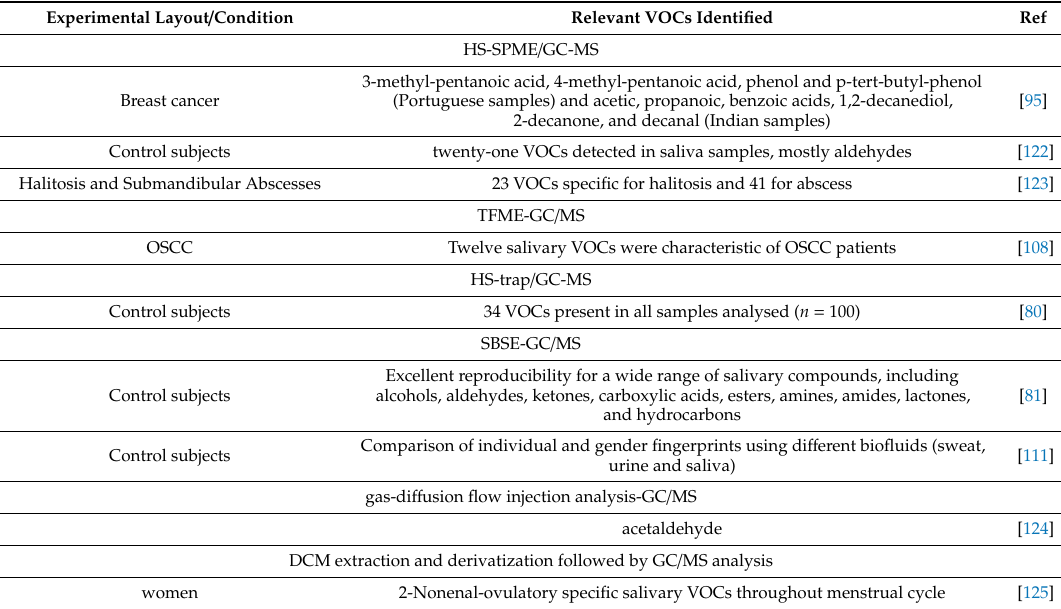
Table 2. Selected examples of di ff erent experimental layouts used to characterize salivary